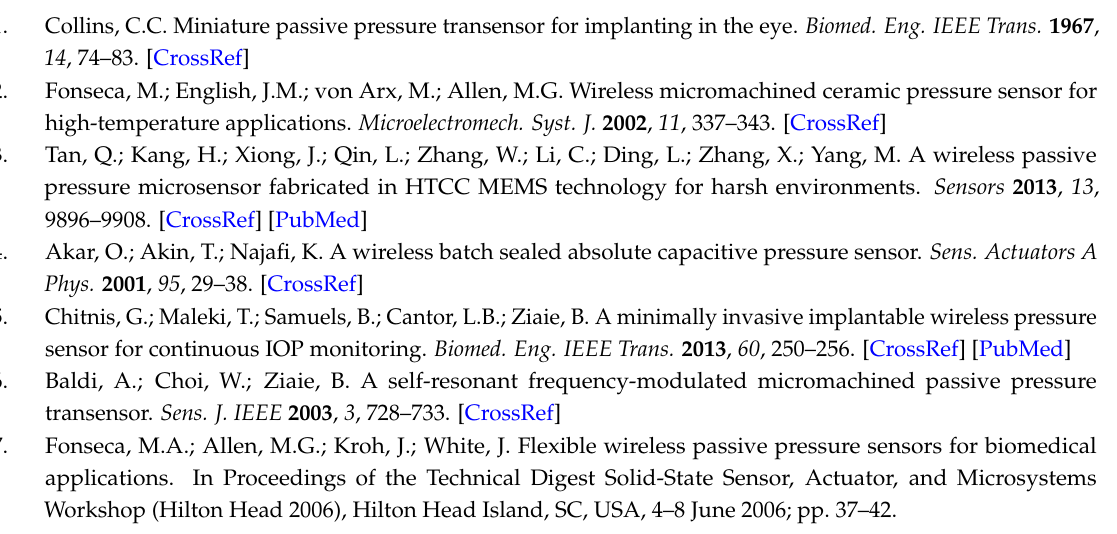
Figure 8. (a) Measured f versus frequency, (b) Measured f versus frequency under different temperatures 0 0 Figure 8. ( a ) Measured f 0 vs. frequency; ( b ) measured f 0 vs. frequency under different